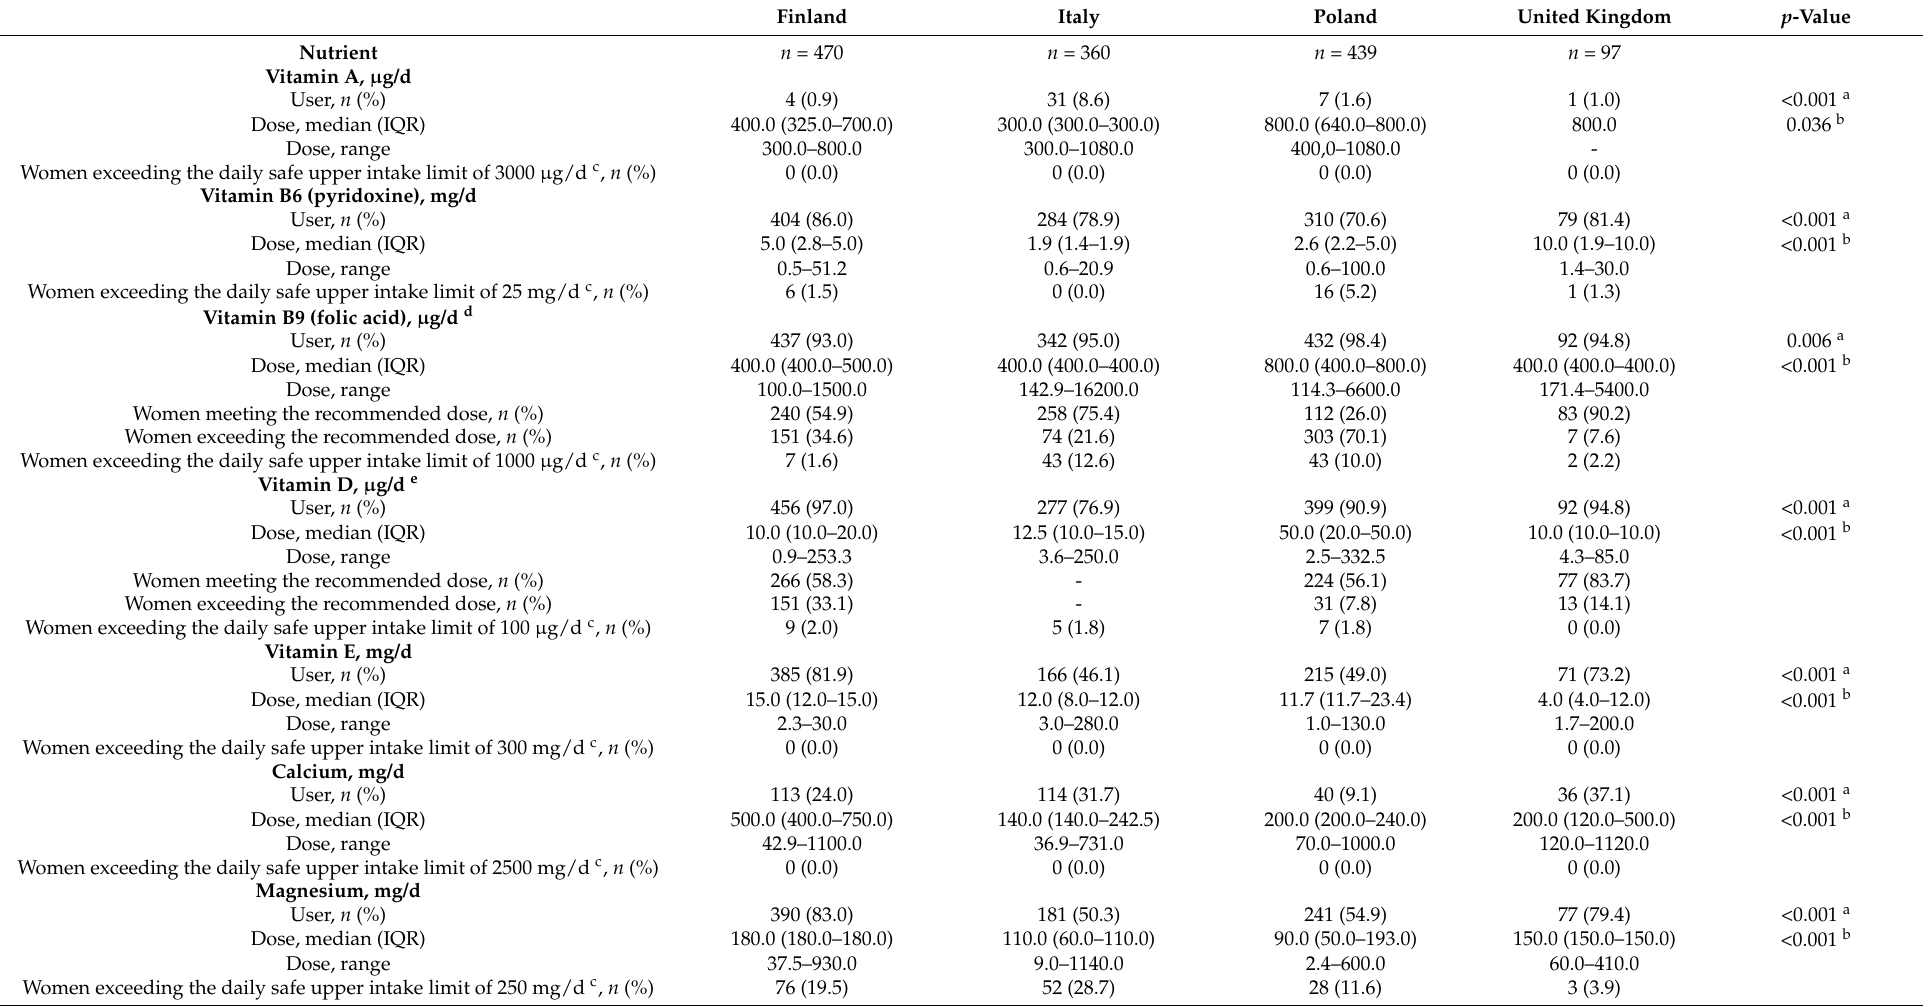
Table 6. Daily intakes of nutrients from food supplements and adherence to food supplement recommendations in pregnant women who reported their supplement use with pictures and/or detailed written